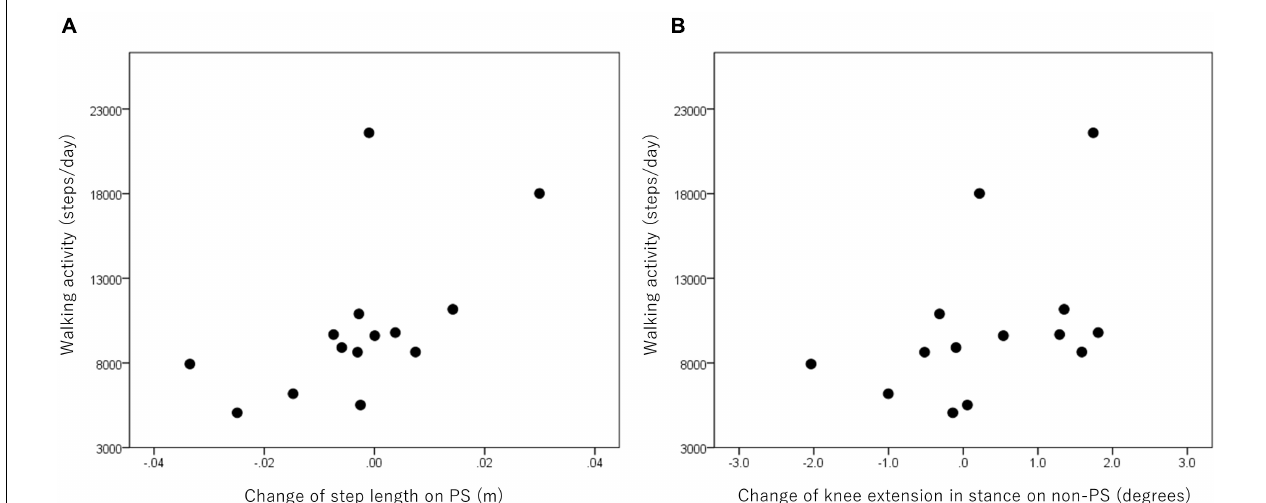
FIGURE 4 | Relationship between walking activity and changes in step length on the paretic side (PS) (A) and knee extension in stance on the non-PS (B) in the poststroke